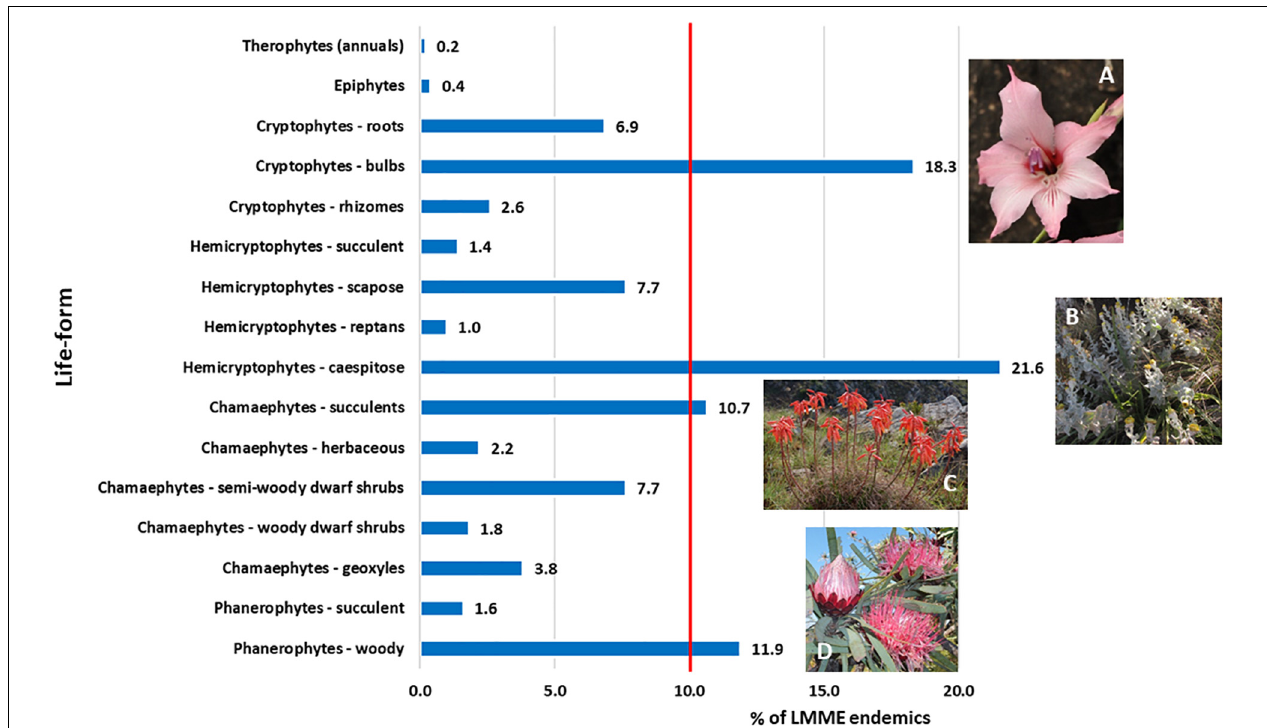
FIGURE 5 | Life-form partitioning among Limpopo–Mpumalanga–Eswatini Escarpment (LMEE) endemic plant taxa. Life-form classes are based on a modified version of the Raunkiaer system (Raunkiaer, 1934); an additional category under chamaephytes was added, namely geoxyles: Geoxylic growth forms of woody subshrubs characterized by massive lignotubers, or underground woody axes, from which emerge aerial shoots which may be ephemeral given their misfit in the existing Raunkiaer system. (A) Gladiolus pavonia Goldblatt and J. C. Manning, an example of the abundant endemic bulbous cryptophytes in the LMEE; (B) Helichrysum lesliei Hilliard, a caespitose hemicryptophyte and an example of the dominant life-form endemic in the LMEE; (C) Aloe chortolirioides A. Berger is an example of a succulent chamaephyte in the LMEE; (D) woody phanerophytes such as Protea curvata N. E. Br. comprise a significant proportion of the LMEE endemic life-forms, many being endemic to the Grassland Biome. Credits: J. E. Burrows (A) , B. C. Turpin (B) , M. C. Lötter (C) , D. Oosthuizen (D)